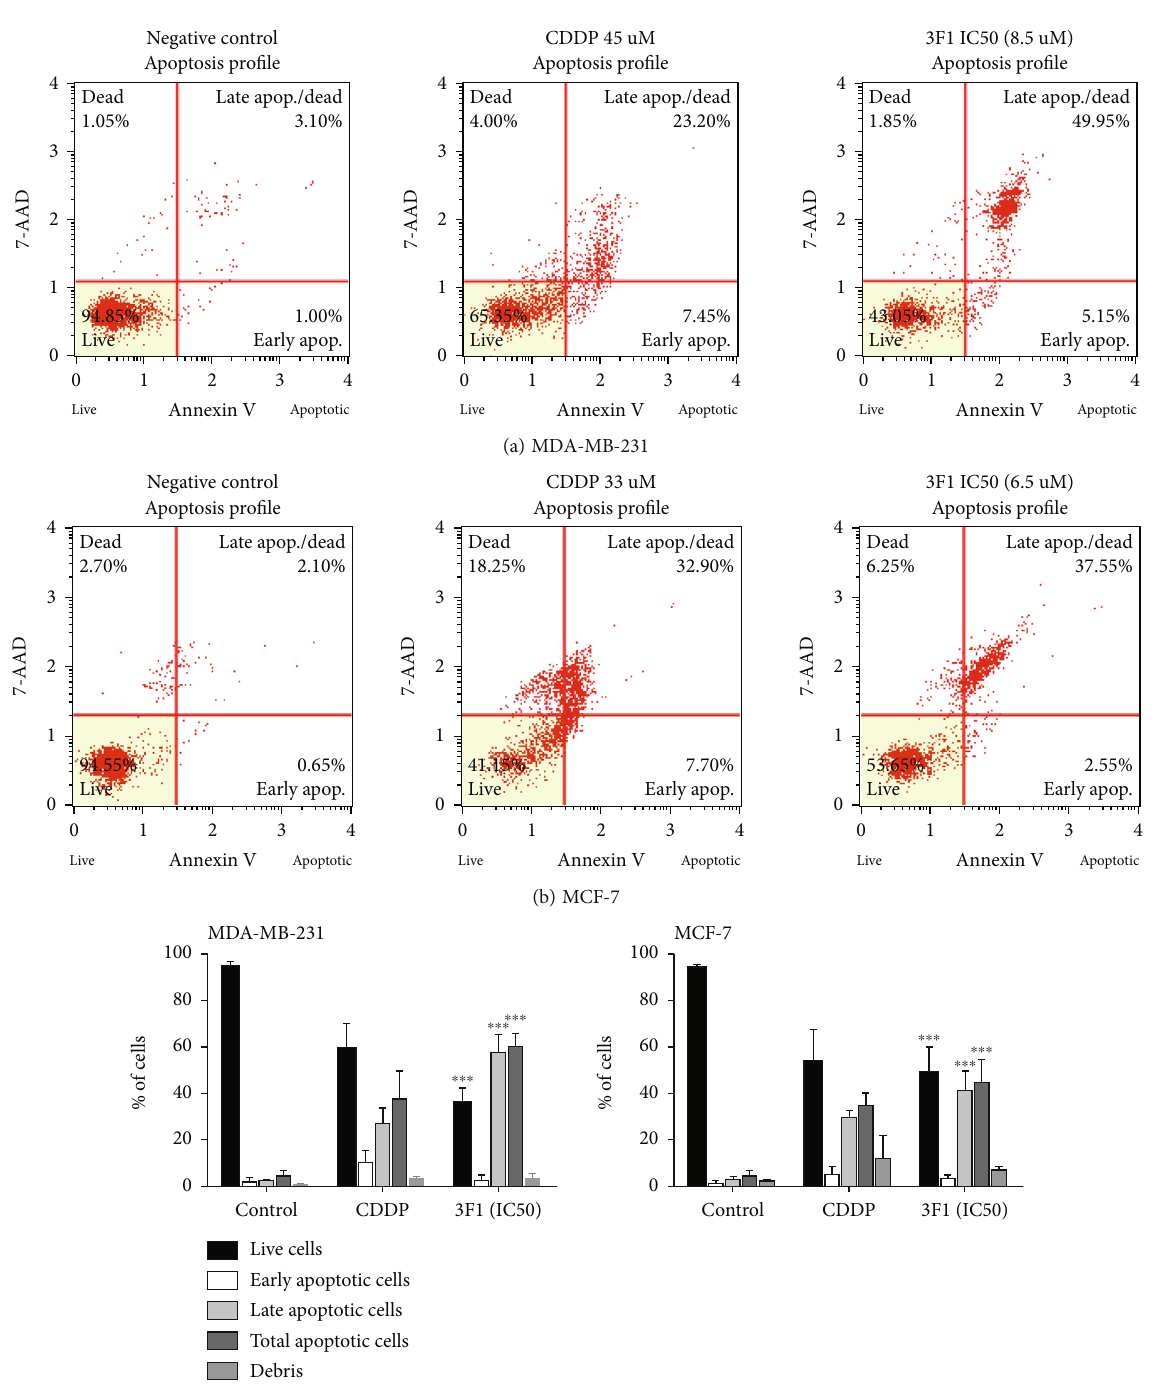
Figure 5: MUSE Annexin V and dead cell assay for detecting apoptosis induction. MDA-MB-231 (a) and MCF-7 (b) cells were treated for 24h with the respective IC dose of the novel gold-based compound 3F1 or cisplatin (CDDP) for the positive control samples or with 0.1% 50 DMSO for the negative controls. The representative scattered plot showed early apoptotic cells and late apoptotic cells in the lower and upper right quadrants. In contrast, live cells and necrotic cells were detected in the lower and upper left quadrant, respectively. Percentage of apoptotic cells (c) represented as the mean ± S : D : of three independent experiments. Statistical signi fi cance was analyzed by two-way ANOVA and a post hoc Tukey ’ s multiple comparison test. ∗∗∗ p < 0 : 001 was considered signi fi cantly di ff